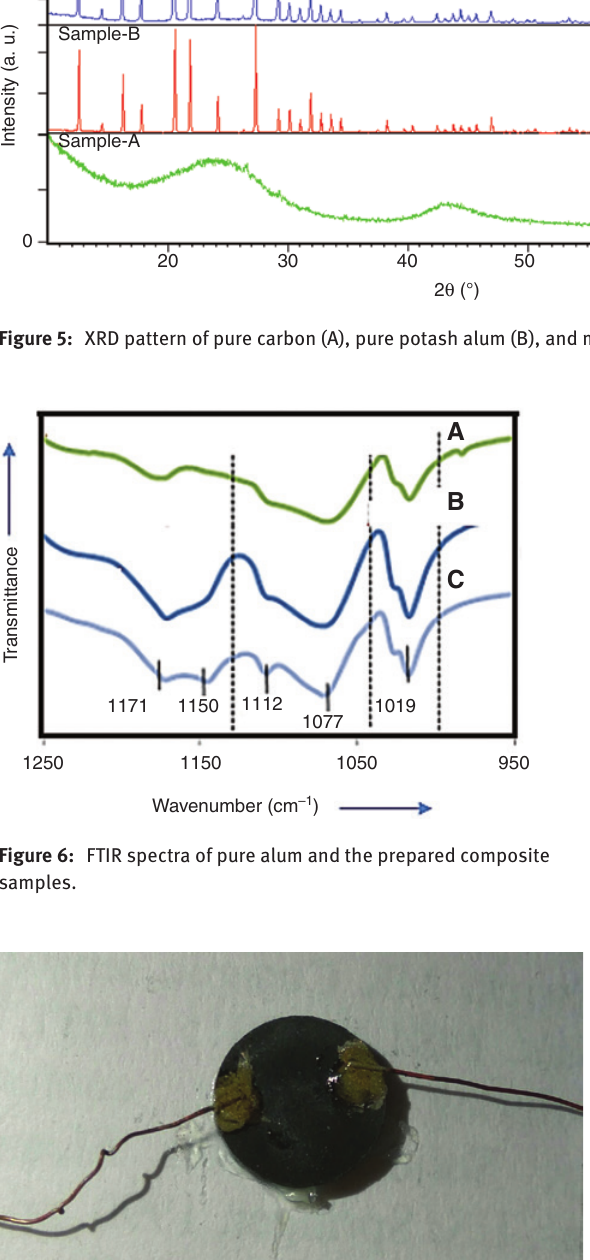
range expanded from 30% to 65% RH. The observation from Figure 8 of the absolute linearity of resistance versus relative humidity for humidity range 30%–65% RH indi- cated the inversely proportional relation in between